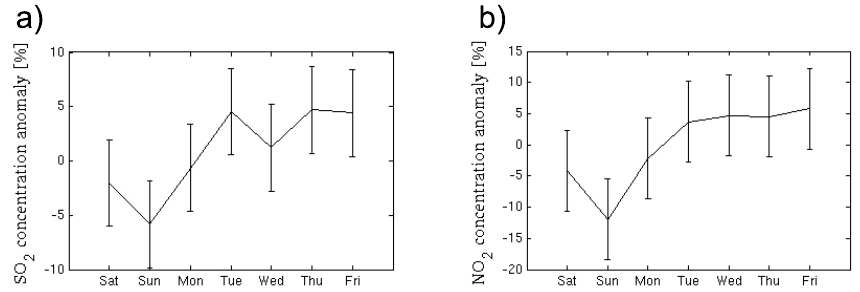
Fig. 2. Weekly cycles of (a) SO 2 anomaly and (b) NO 2 anomaly at the mean of four rural stations in the Black Triangle, 1983–2008 (exact time series varies between the stations, see Sect. 2). Vertical bars show ± 1 standard